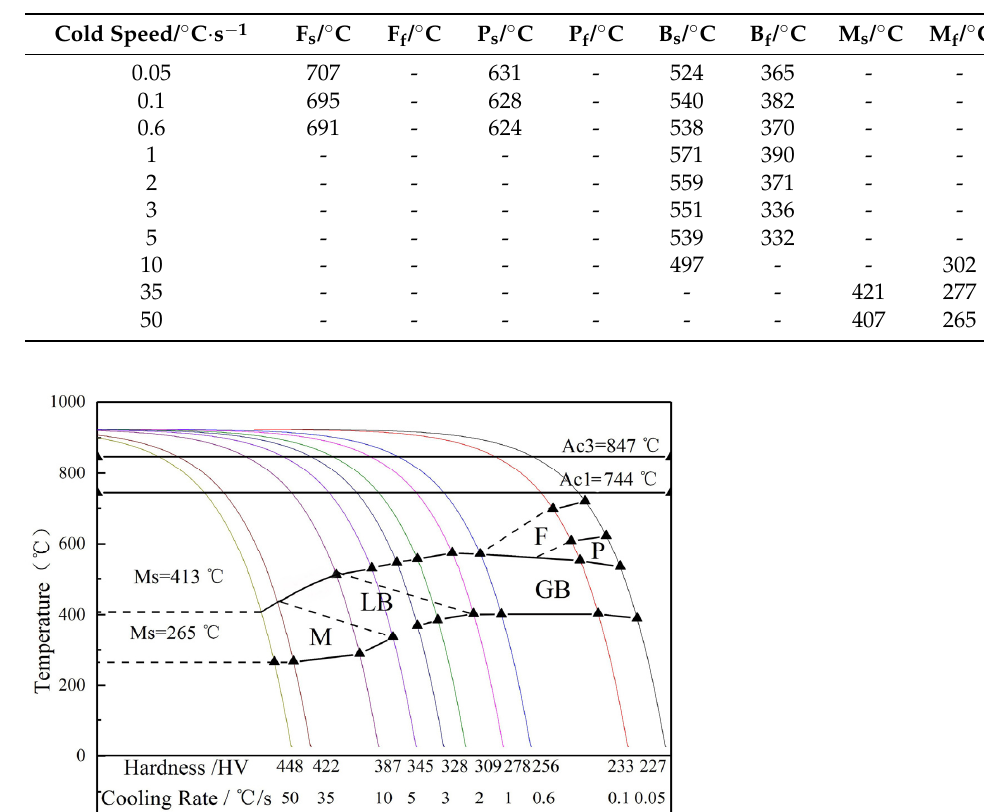
Table 4. The phase transition points of the different specimens heated at 830 ◦ C.